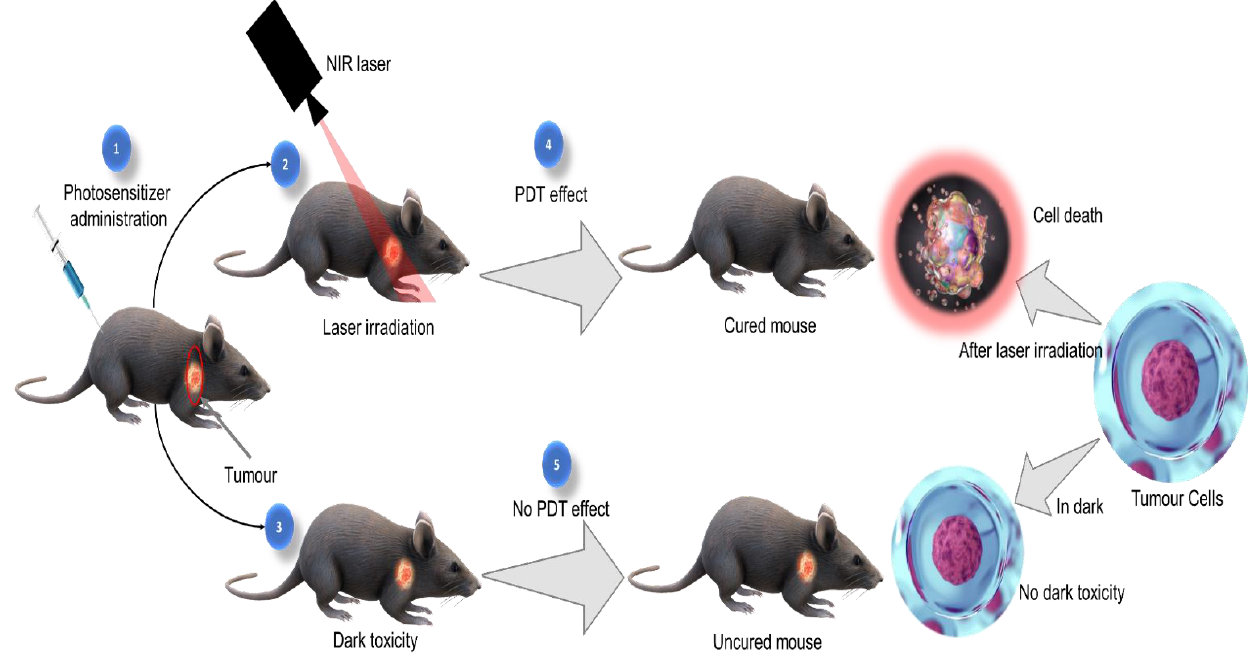
Figure 1. Photodynamic therapeutic effect.